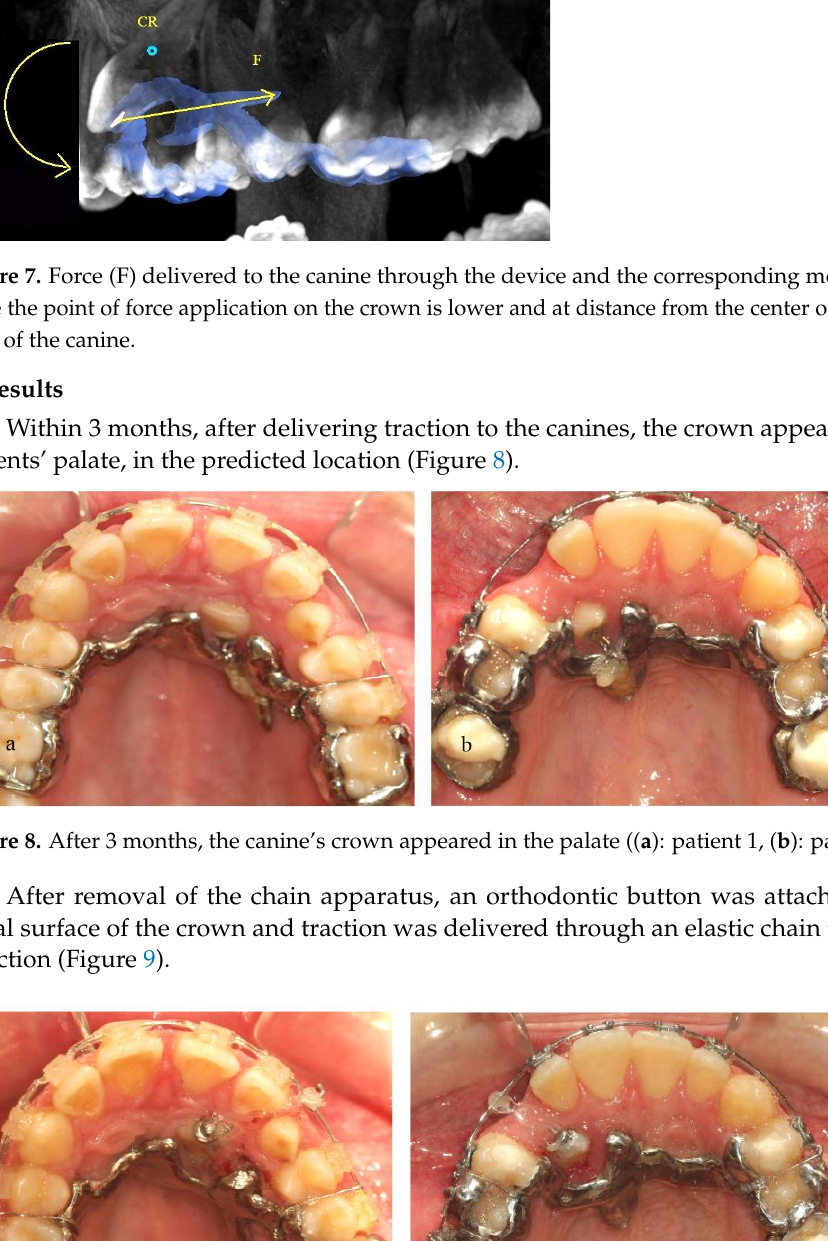
Figure 6. The gold chain apparatus mounted to the projection of the device, through an elastic chain (( a ): patient 1, ( b ): patient 2).